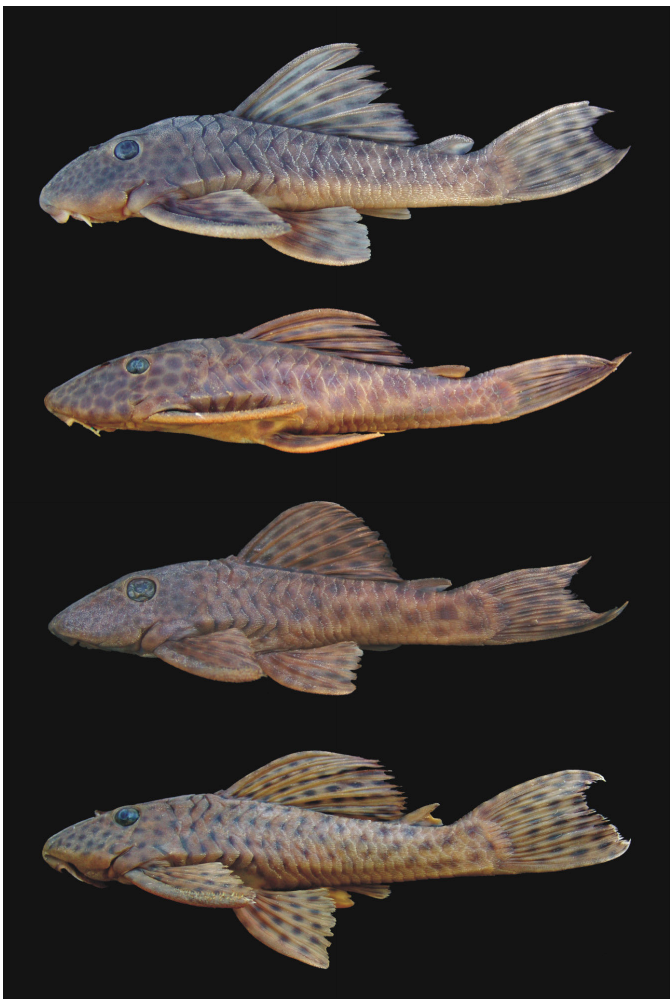
FIGURE 9 | Hypostomus hermanni , from different sub basins in the Upper Paraná River basin. From top to bottom: NUP 16526, 134.4 mm SL, Tietê River; NUP 14995, 152.2 mm SL, Tibagi River; NUP 5584, 128.1 mm SL, Piquiri River; NUP 5402, 175.1 mm SL, Ivaí